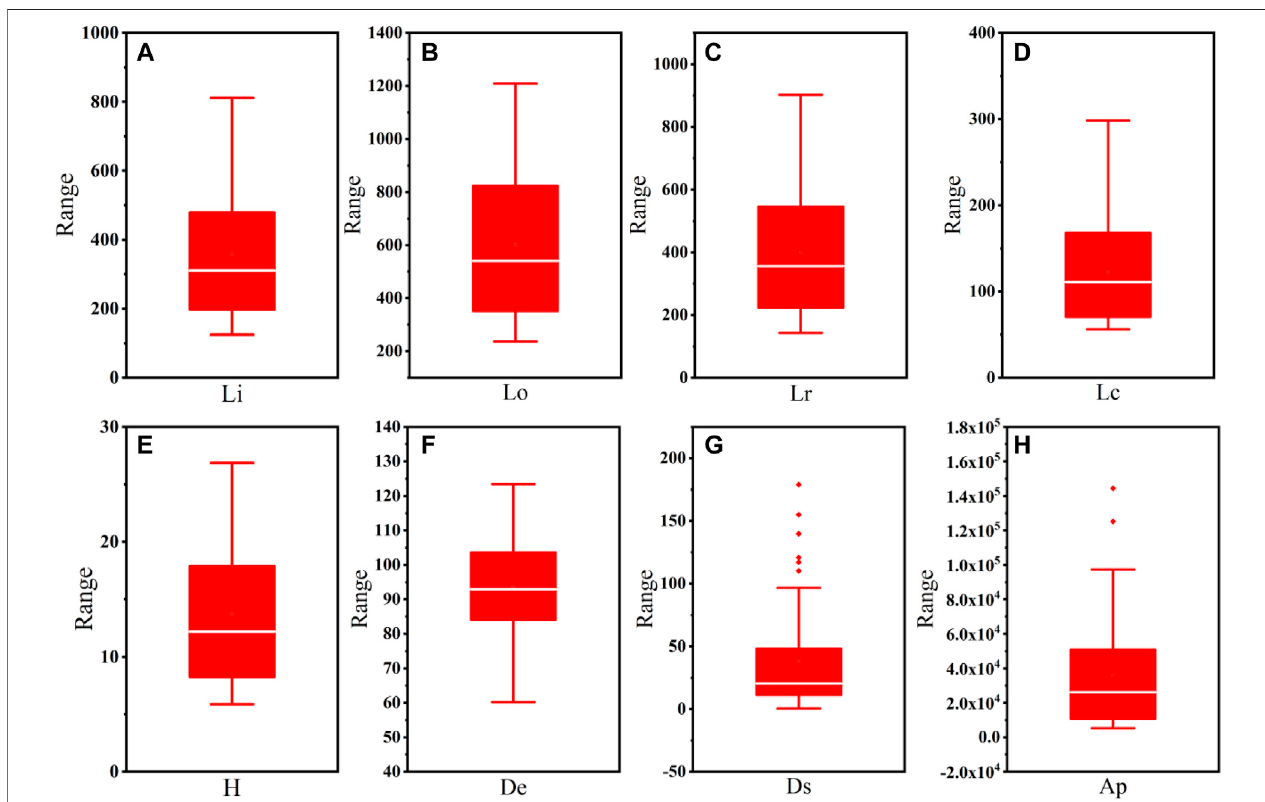
FIGURE 4 | Box line diagram of the morphological parameters of the crescent-shaped sand